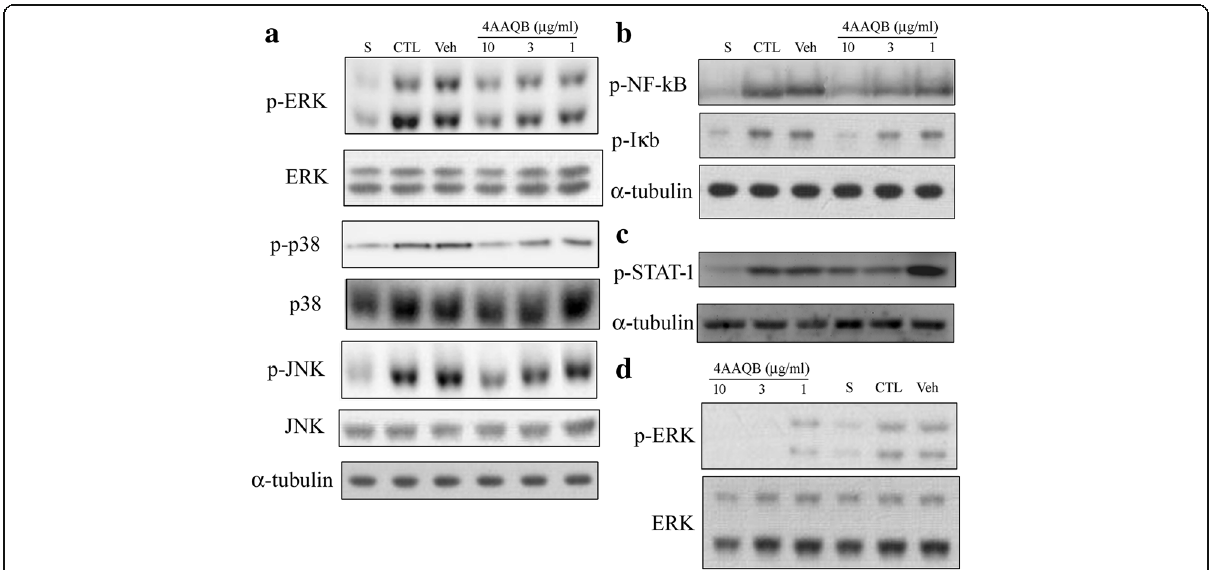
Fig. 5 Effects of 4AAQB on the LPS-induced activation of MAP kinases, IkB α , NF κ B p65 and STAT1 in RAW 264.7 macrophages and peritoneal macrophages. RAW264.7 cells were treated with various concentration of 4AAQB and stimulated with LPS (100 ng/ml) for 30 min. Cells were harvested and total cell extracts were prepared. a Phosphorylated-ERK, phosphorylated-JNK, phosphorylated-p38, or b Phosphorylated-I κ B α and NF κ B p65 subunit and c Phosphorylated-STAT1 were detected by Western blot analysis. Total ERK, JNK, p38 and α -tubulin were used as in- ternal standard. d Peritoneal macrophages were treated with various concentration of 4AAQB and stimulated with LPS (100 ng/ml) for 30 min. Phosphorylated-ERK and total ERK were detected by Western blot analysis